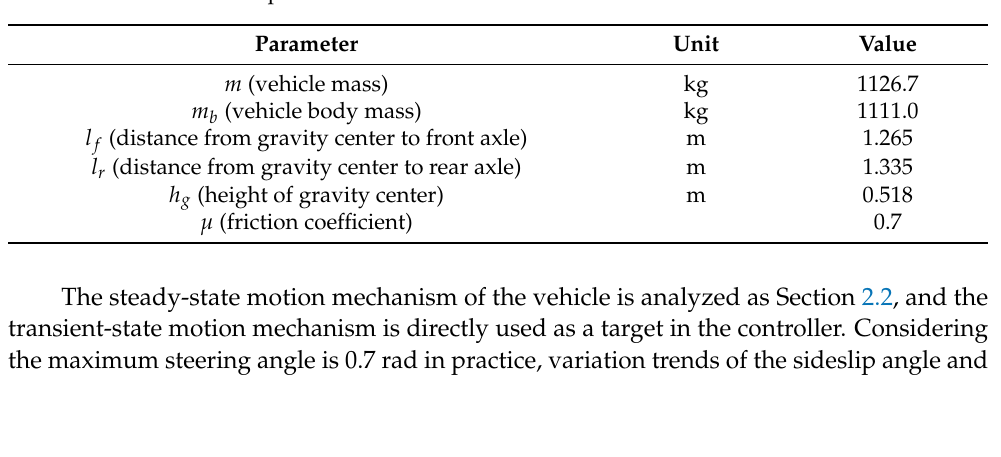
Table 1. The vehicle main